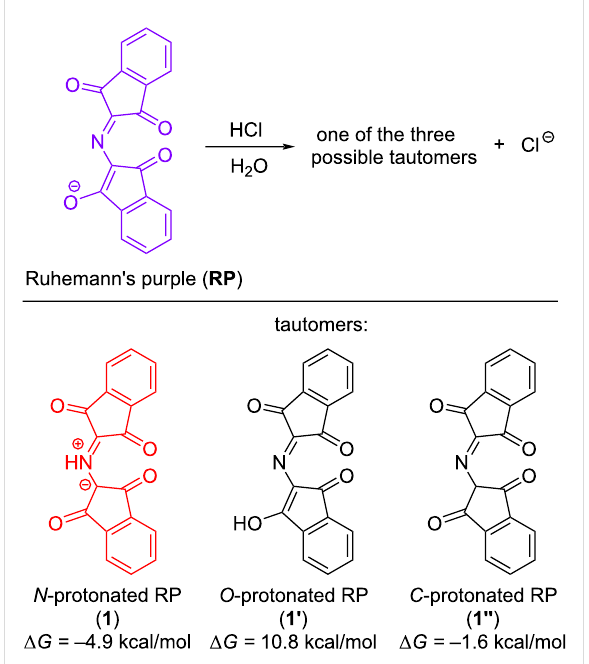
Scheme 7: The acid–base reaction of Ruhemann's purple with hydro- chloric acid and relative Gibbs free energy change ( Δ G , kcal/mol) for acid–base reactions resulting in the formation of three protonated forms of Ruhemann's